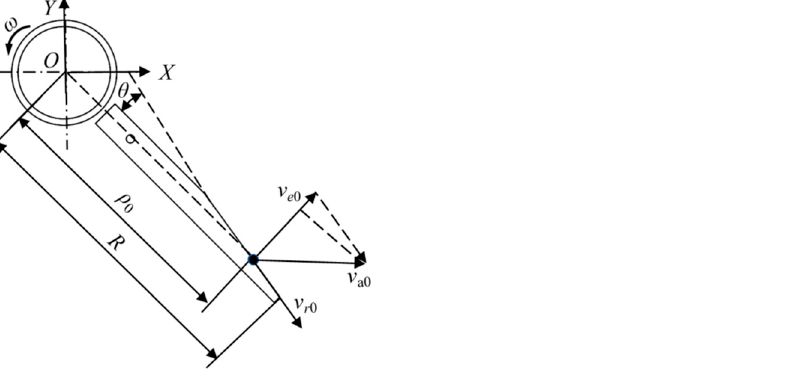
Figure 2. Motion analysis of the collision process between the knife and straw.